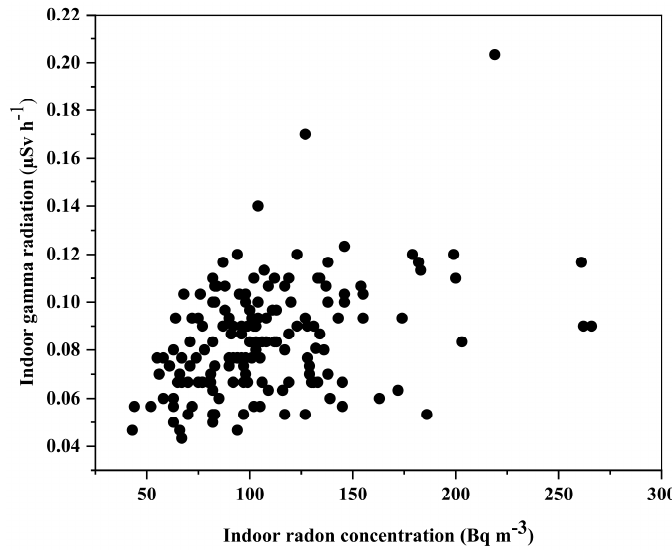
Figure 5. Correlation between indoor ambient-equivalent dose rate and indoor radon in the bauxite-bearing areas of southern